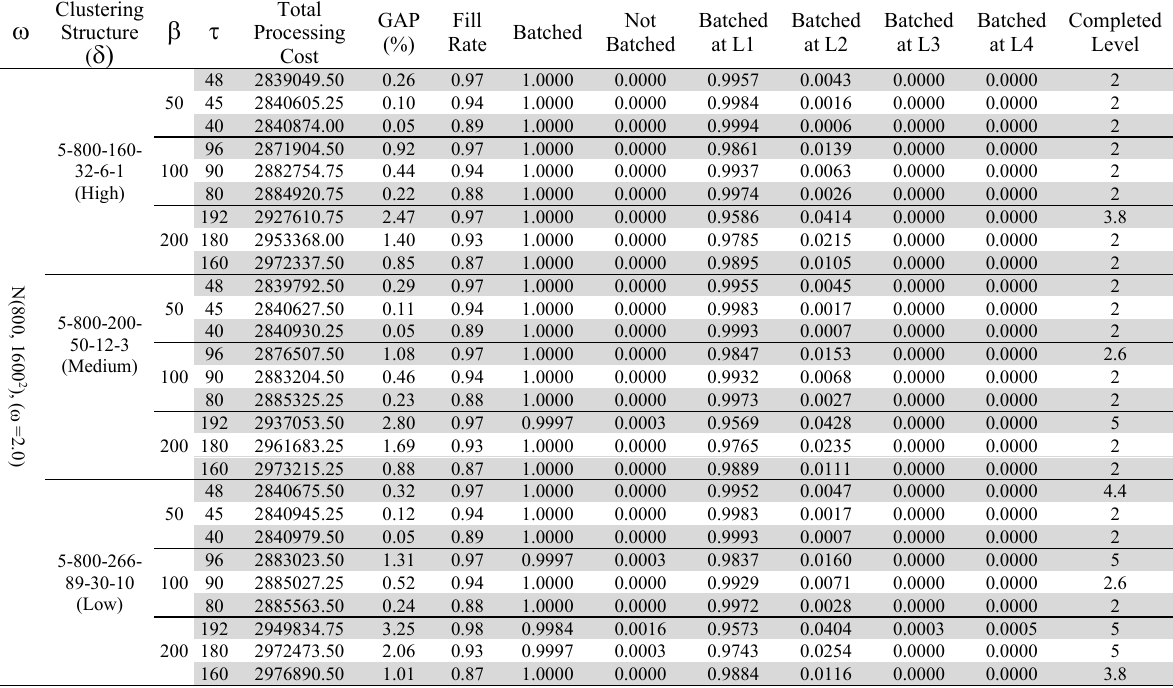
Results for demand scenario S-27 with 5-Level non-exclusive AHCS Clustering 